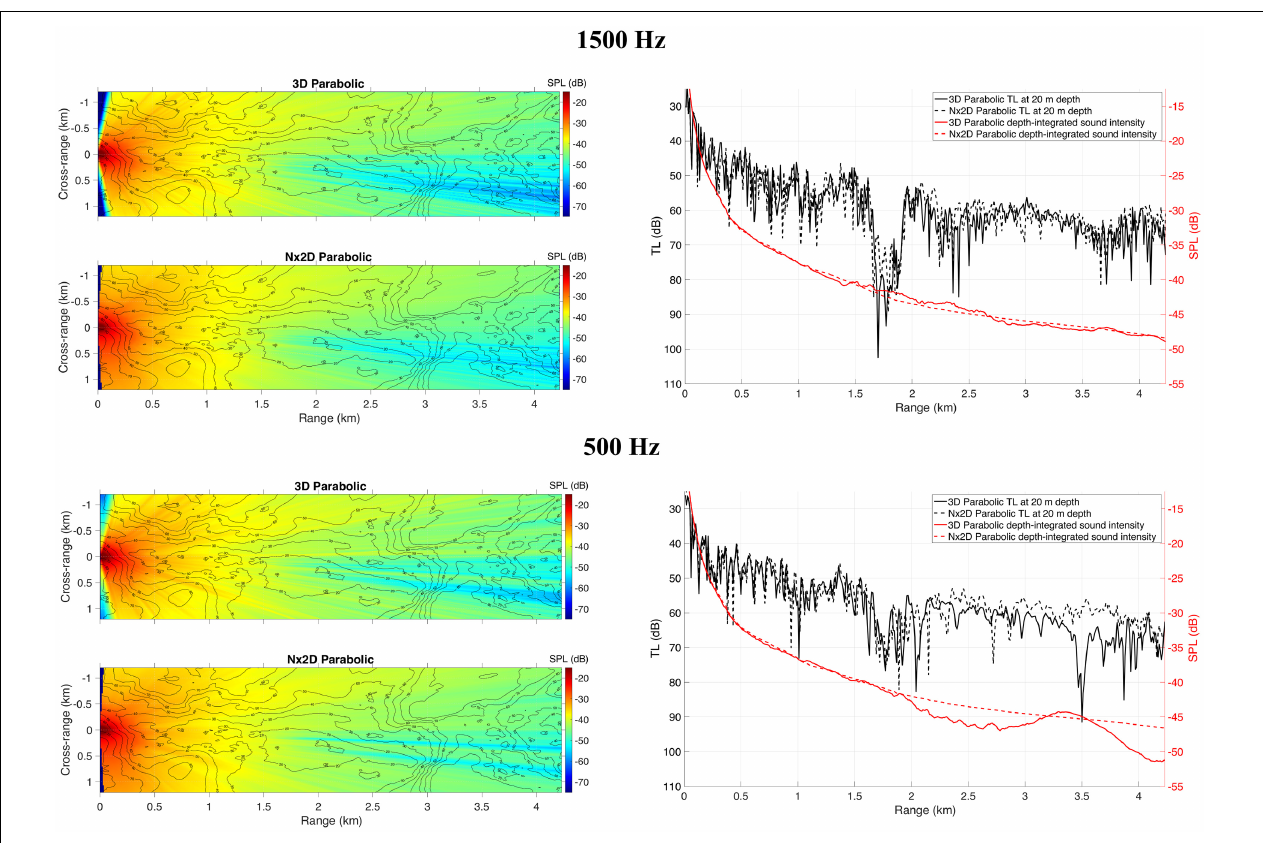
FIGURE 7 | Comparison between 3D parabolic and Nx2D parabolic results for sound propagating along a sand bar and SSP range-dependent [ c ( r , z ) ] and for 1500 Hz (top panel) and 500 Hz (bottom panel) . Plots on the left are for depth-integrated sound intensity from a 0 dB source. Plots on the right present depth-integrated sound intensity and TL at 20 m depth for cross-range =